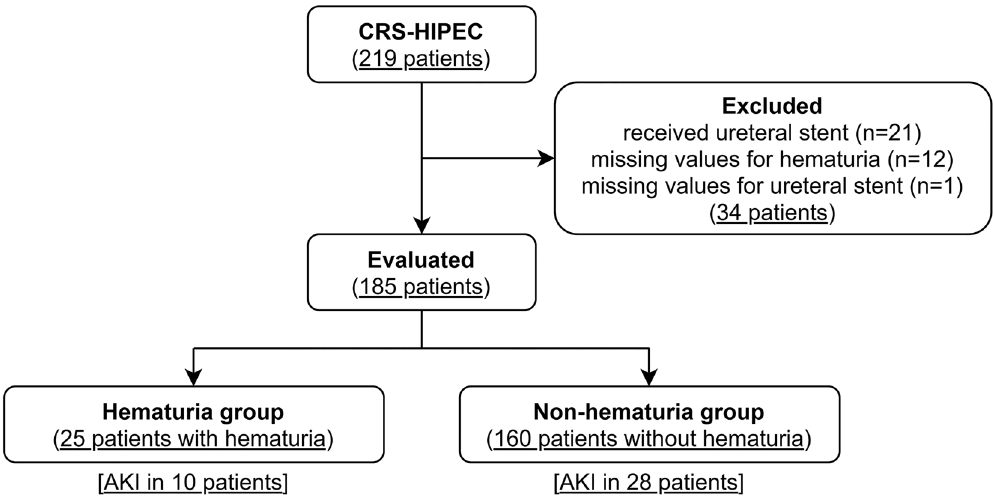
Figure 1: Flow diagram of the study population. CRS-HIPEC, cytoreductive surgery plus hyperthermic intraperitoneal chemotherapy; AKI, acute kidney